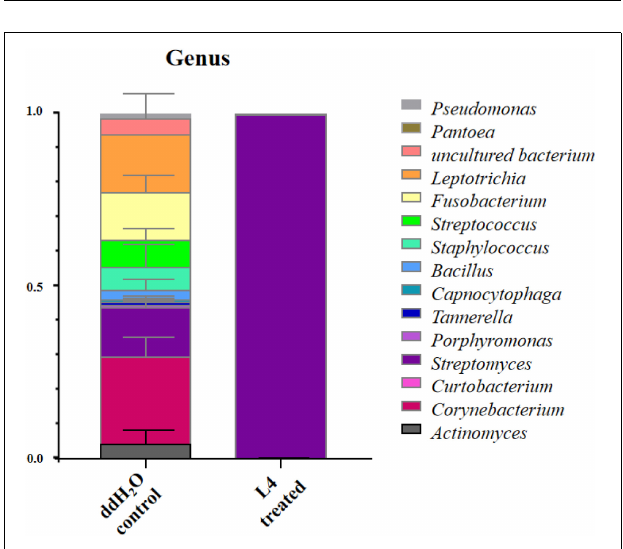
FIGURE 5 | Endophytic bacterial community at genus level in the root of A . thaliana after treatment with S . lincolnensis